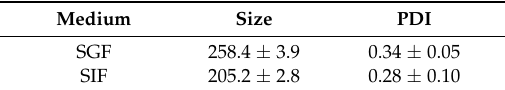
Table 4. Physical stability of SLM-NLCs in simulated gastrointestinal fluids (SGF: simulated gastric fluid; SIF: simulated intestinal fluid). Results are expressed as means ± standard deviation of three